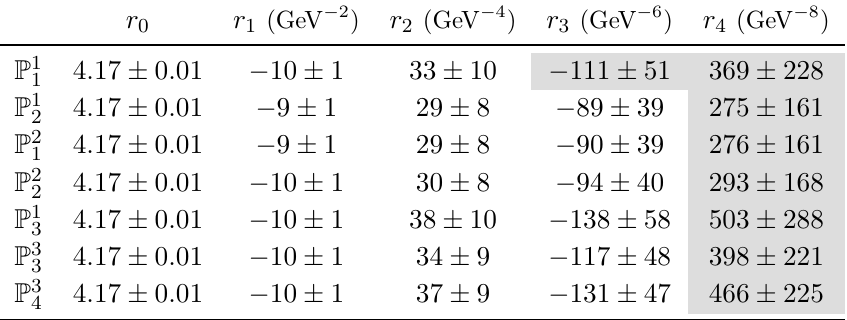
Table 5 . Values for the first five Taylor coefficients r n of the ghost propagator predicted by the partial Padé approximants (with statistical errors). Shaded results have uncertainties larger than 45% and do not enter our final values.